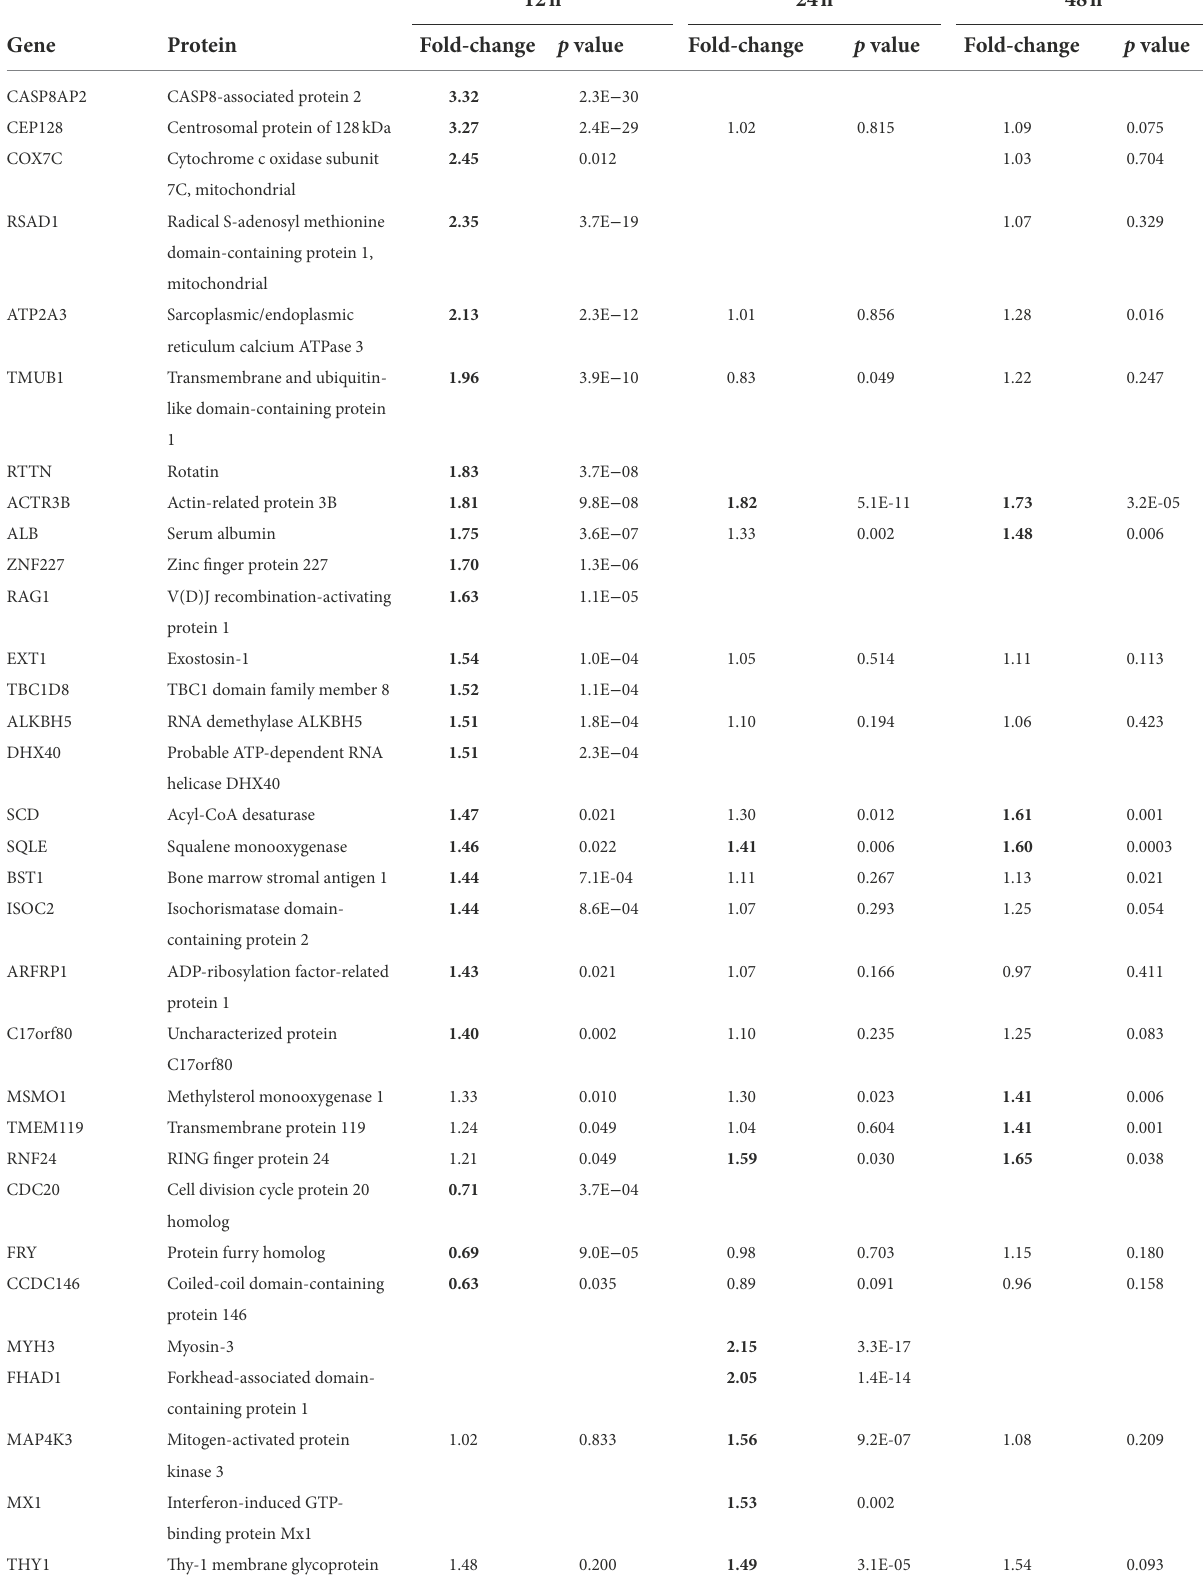
TABLE 2 MRC-5 proteins dysregulated ≥ 1.4-fold by OC43